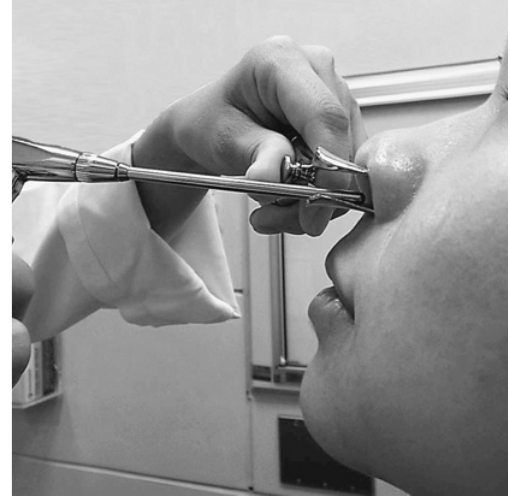
F i g . 1 Usin g nasal spra y near the nostrils of patient